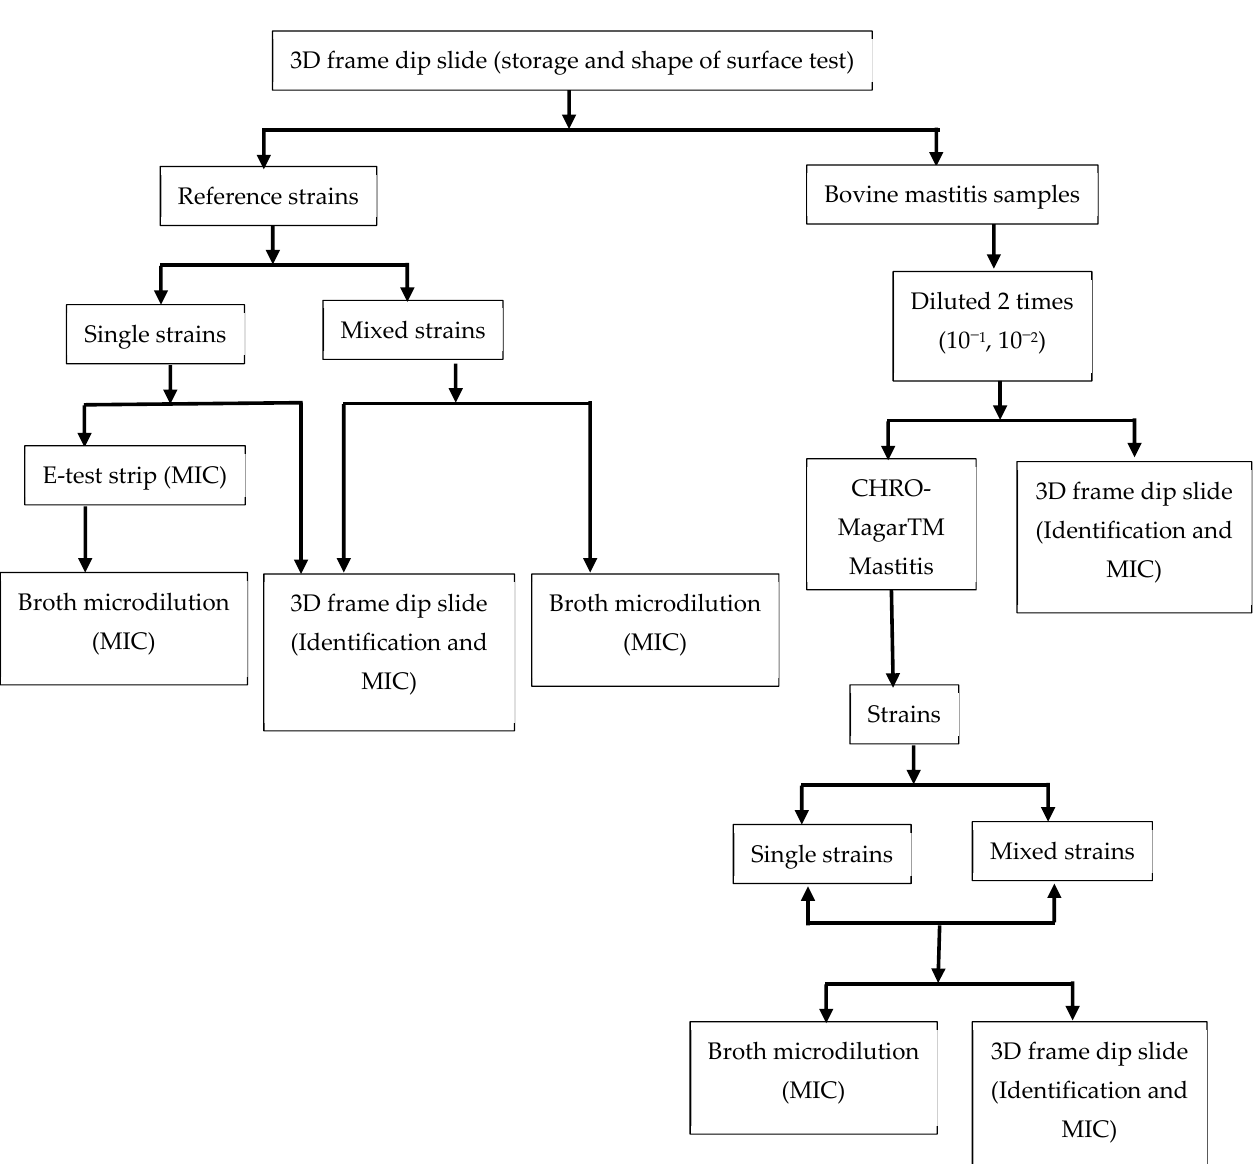
Figure 3. Flowchart showing isolation, identification and sensitivity testing for reference and mastitis strains